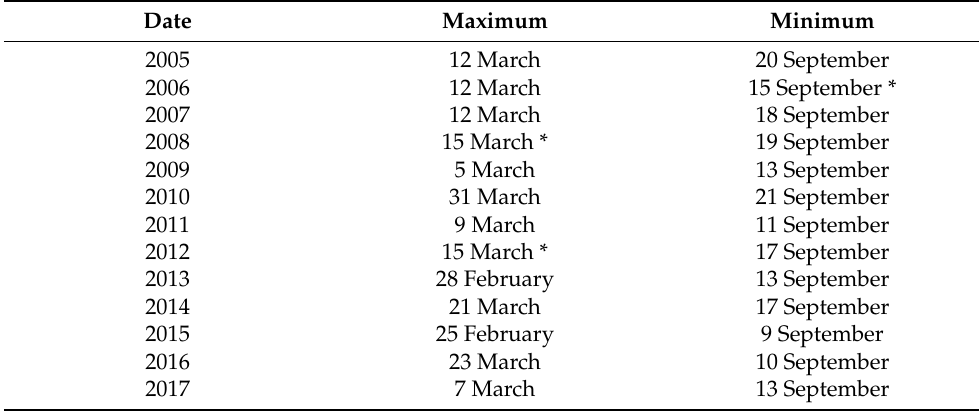
Table 1. Dates of Arctic sea ice maximum extent and minimum